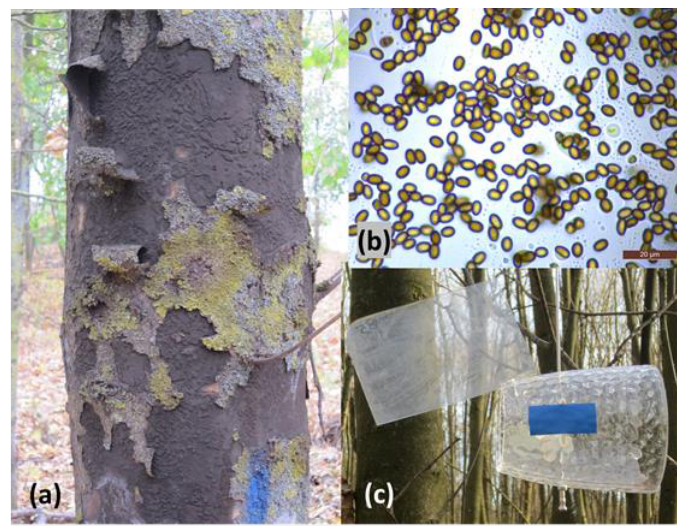
Figure 2. ( a ) Sycamore maple with sooty bark disease: extensive spore layers of Cryptostroma corticale ; ( b ) conidia of C. corticale viewed under a light microscope; ( c ) spore trap with an applied microscope slide in vertical orientation behind the blue stripe.